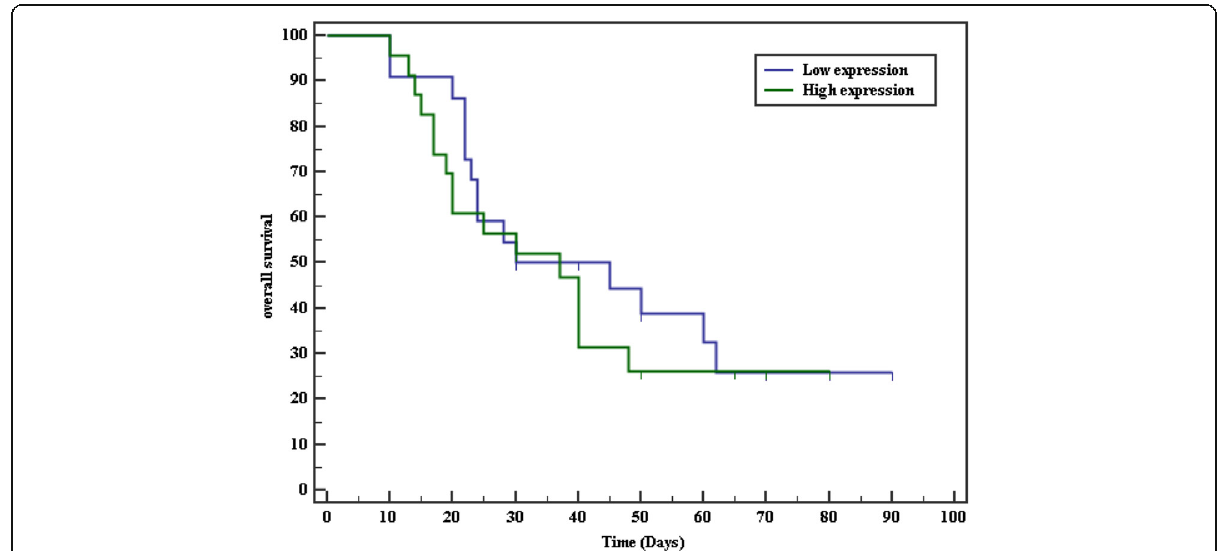
Fig. 3 Kaplan-Meier curve of the overall survival in relation to the level of gene